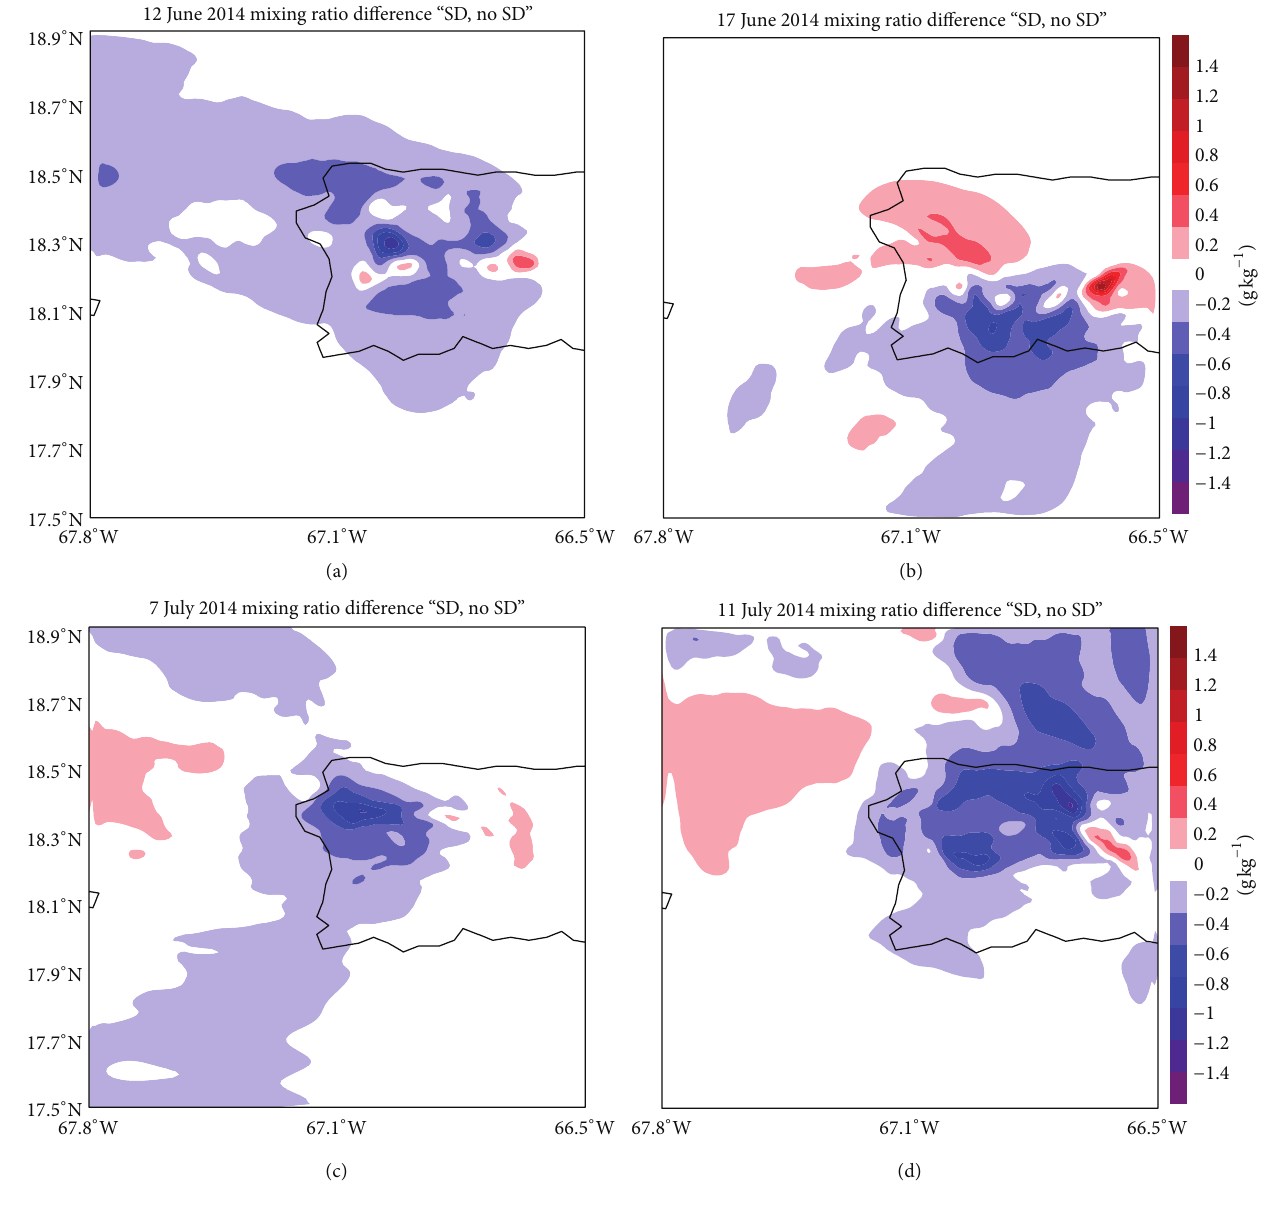
Figure 13: RAMS generated PBL averaged mixing ratio differences for 12 June 2014 (a), 17 June 2014 (b), 7 July 2014 (c), and 11 July 2014